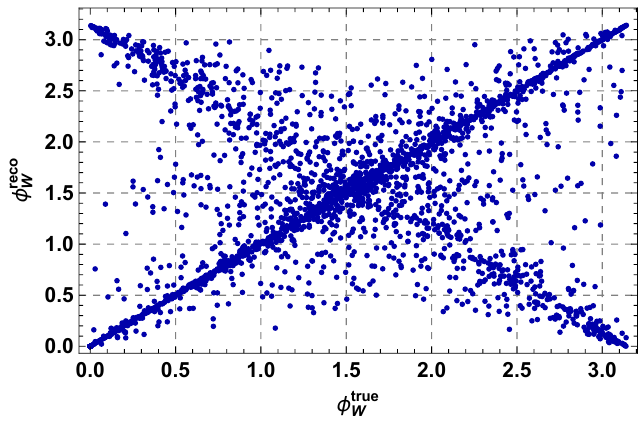
Figure 1 . Parton level values of the (cid:30) W angle de(cid:12)ned in eq. (2.12) built assuming a randomly chosen p (cid:23) solution against the same angle where the real, but experimentally unaccessible, value of z p (cid:23) has been used. The ambiguity (cid:30) W ! (cid:25) (cid:0) (cid:30) W is z